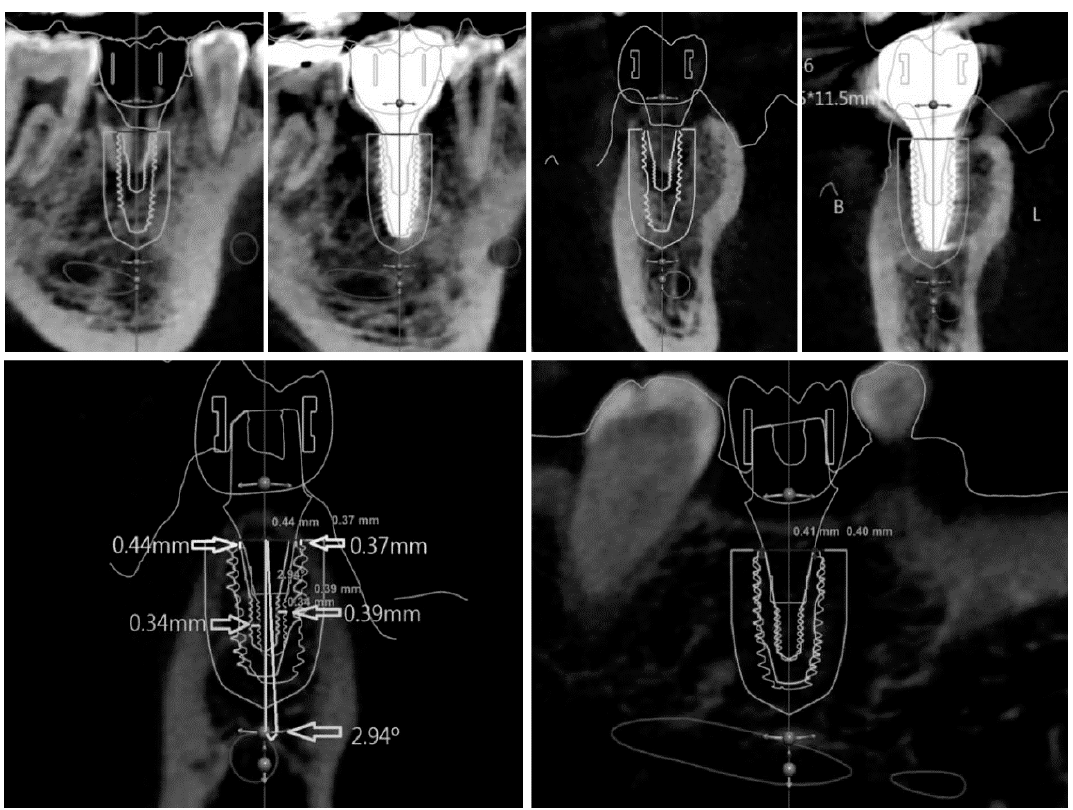
Figure 5. Displacement measurement by direct method. The planned position and the placed position are superimposed.